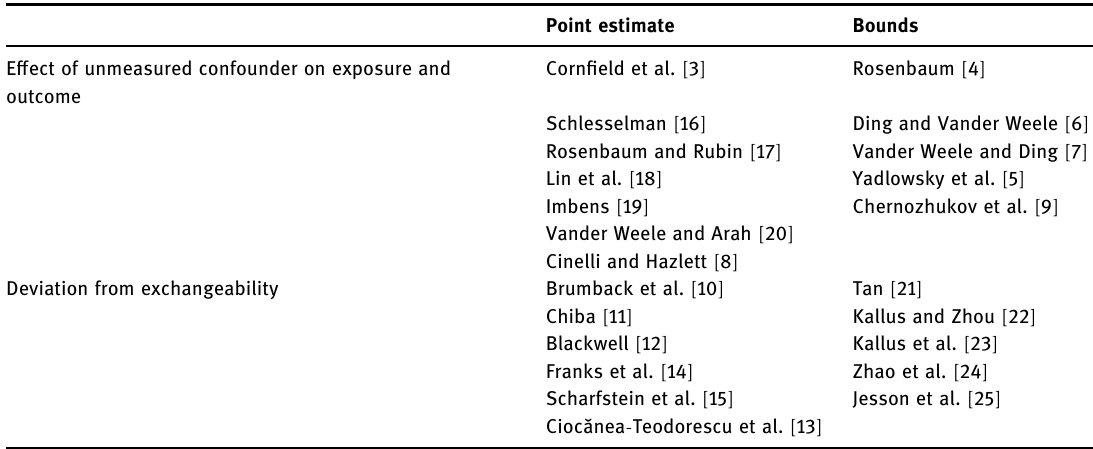
Table 1: Di ff erent types of sensitivity analyses, structured by the type of sensitivity parameters ( the rows ) and type of inference about the target causal e ff ect ( the columns